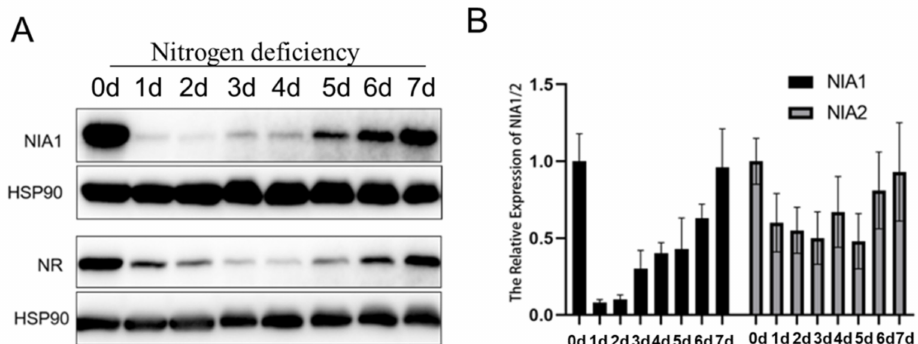
Figure 5. Nitrogen deficiency dynamically regulates the expression level of NIA1. ( A ) Western blot of the proteins extracted from seedlings under the indicated treatments by the NIA1 antibody and NR antibody. The quantification of relative levels of NIA1 or NR proteins are shown below; ( B ) gene expression analysis of NIA1 or NIA2 transcripts in Col-0 under the indicated treatments. Three biological